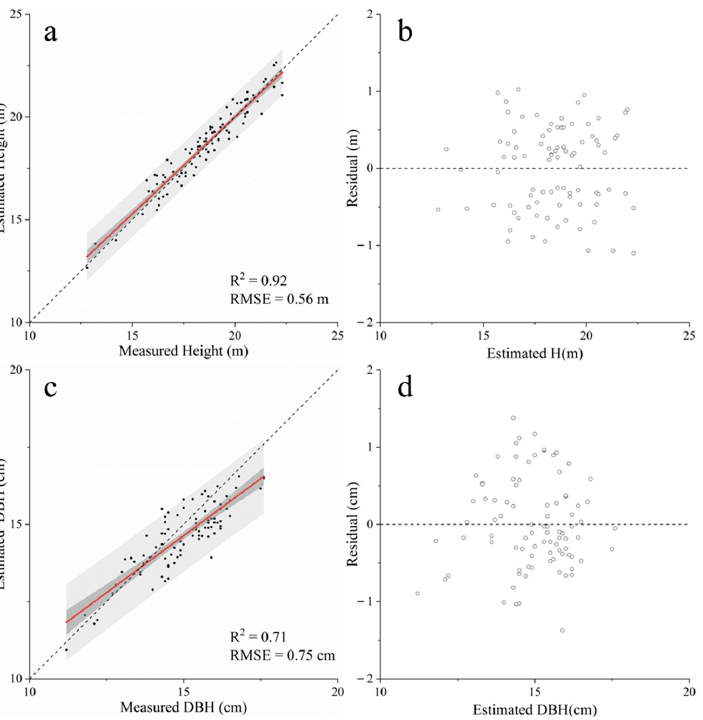
Figure 5. Comparison of the estimated tree height (H) and diameter at breast height (DBH) of 89 trees with the measured values on the ground, and analysis of the residuals of the estimated values. The top two figures: regression ( a ) and residuals ( b ) of H; bottom two figures: regression ( c ) and